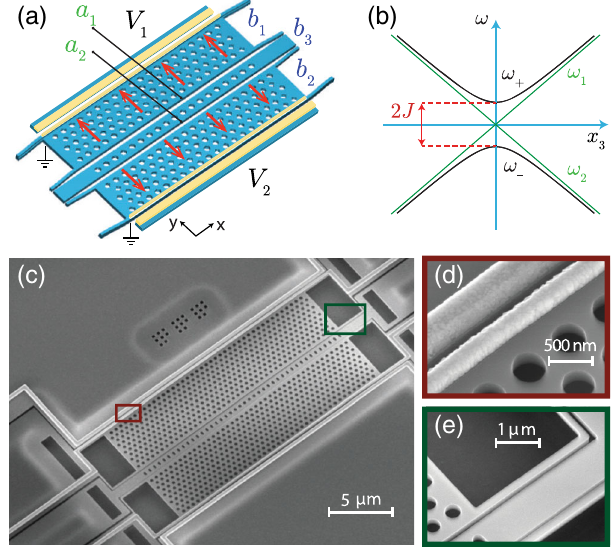
FIG. 1. (a) Double-slotted photonic crystal cavity with optical cavity resonances ( a 1 , a 2 ) centered around the two slots, and three fundamental in-plane mechanical resonances corresponding to motion of the outer slabs ( b 1 , b 2 ) and the central nanobeam ( b 3 ). Tuning the equilibrium position of the outer slabs b 1 and b 2 , and consequently the slot size on either side of the central nanobeam, is achieved by pulling on the slabs (red arrows) through an electrostatic force proportional to the square of the voltage applied to capacitors on the outer edge of each slab. (b) Dispersion of the optical modes as a function of x 3 , the in- plane displacement of the central nanobeam from its symmetric equilibrium position. Because of tunnel coupling at a rate J , the slot modes a 1 and a 2 hybridize into the even and odd supermodes a þ and a − , which have a parabolic dispersion near the central anticrossing point ( ω 1 ¼ ω 2 ). (c) SEM image of a fabricated double-slotted photonic crystal device in the silicon-on-insulator material system. (d) Zoom-in SEM image showing the capacitor gap ( ∼ 100 nm) for the capacitor of one of the outer slabs. (e) Zoom-in SEM image showing some of the suspending tethers of the outer slabs which are of length 2 . 5 μ m and width 155 nm. The central beam, which is much wider, is also shown in this